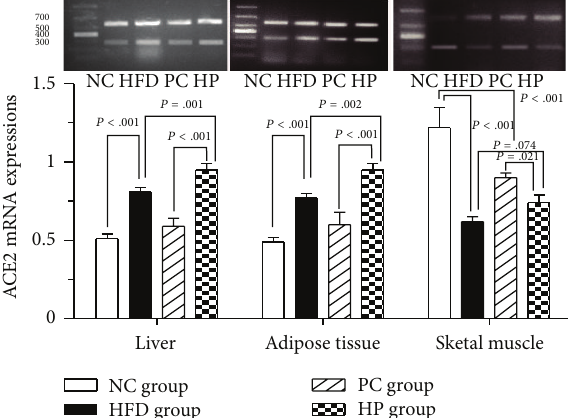
Figure 2: Effects of pioglitazone on ACE2 mRNA expression in insulin-sensitive tissues in rats fed a high-fat diet. In liver and adipose tissue, ACE2 mRNA expression was significantly greater in the HP group compared with the HFD group. In skeletal muscle, ACE2 mRNA expression did not differ between the HFD and HP groups. NC, normal control; HFD, high-fat diet; PC, pioglitazone control; HP, high-fat diet plus